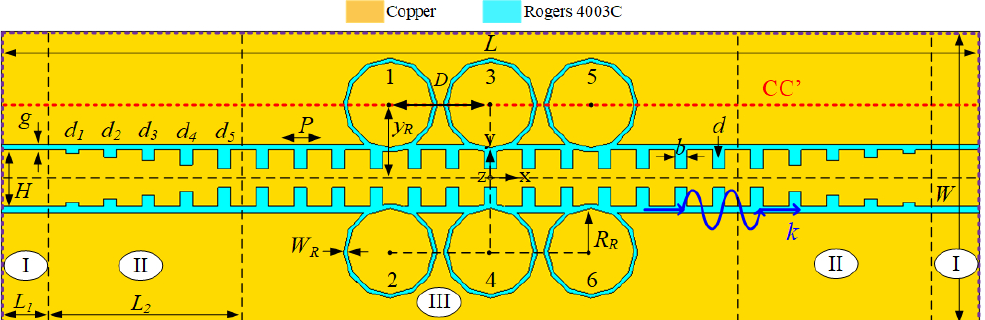
Figure 1. Schematic of the proposed D-BRF through interaction between the coupled circular ring resonators (CCRRs) and the Spoof Surface Plasmon Polariton (SSPP)-based transmission lines